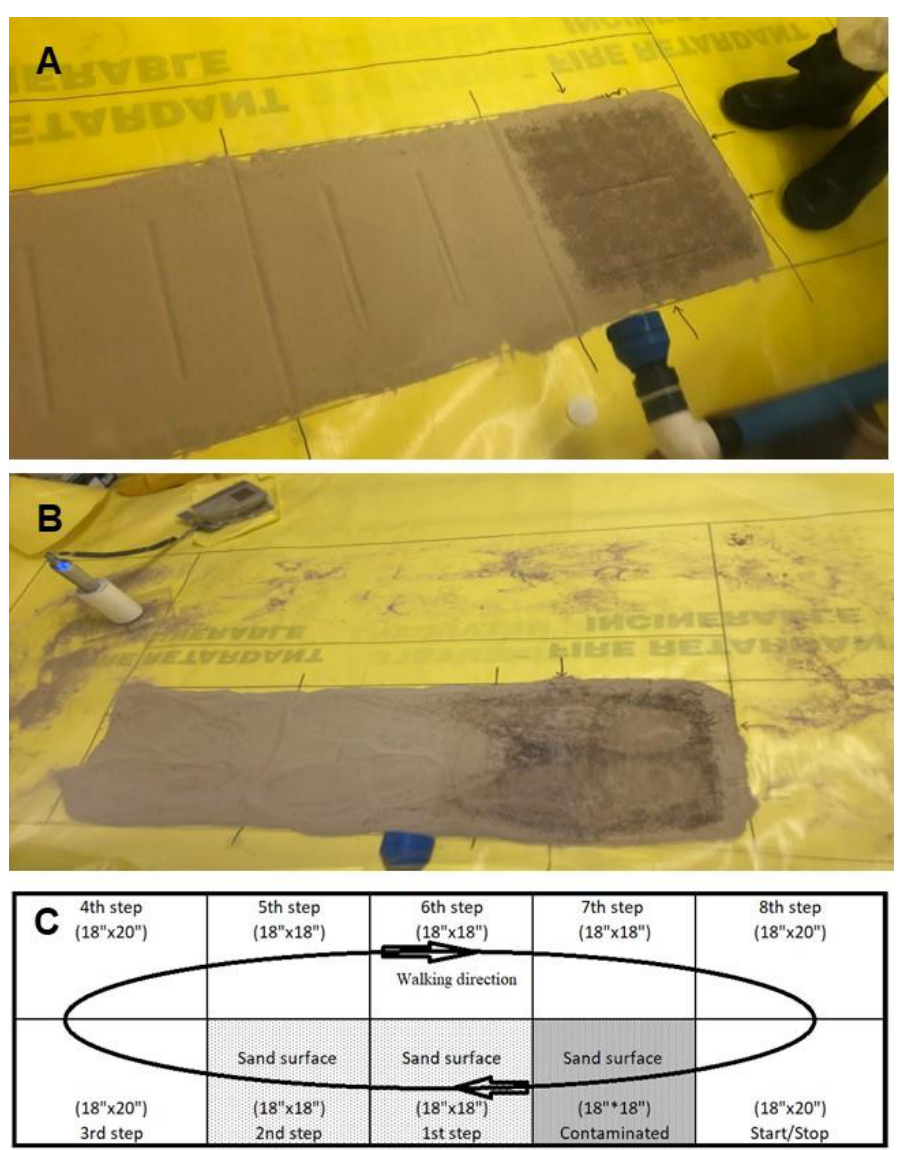
Figure 8. Appearance of Circuit Walking Path ( A ) Pre- and Post- ( B ) Walking for ( C ) Schematic Diagram for Circuit Walking Path Experiment. Panel ( B ) also depicts the use of the radiation detector for this type of experiment.